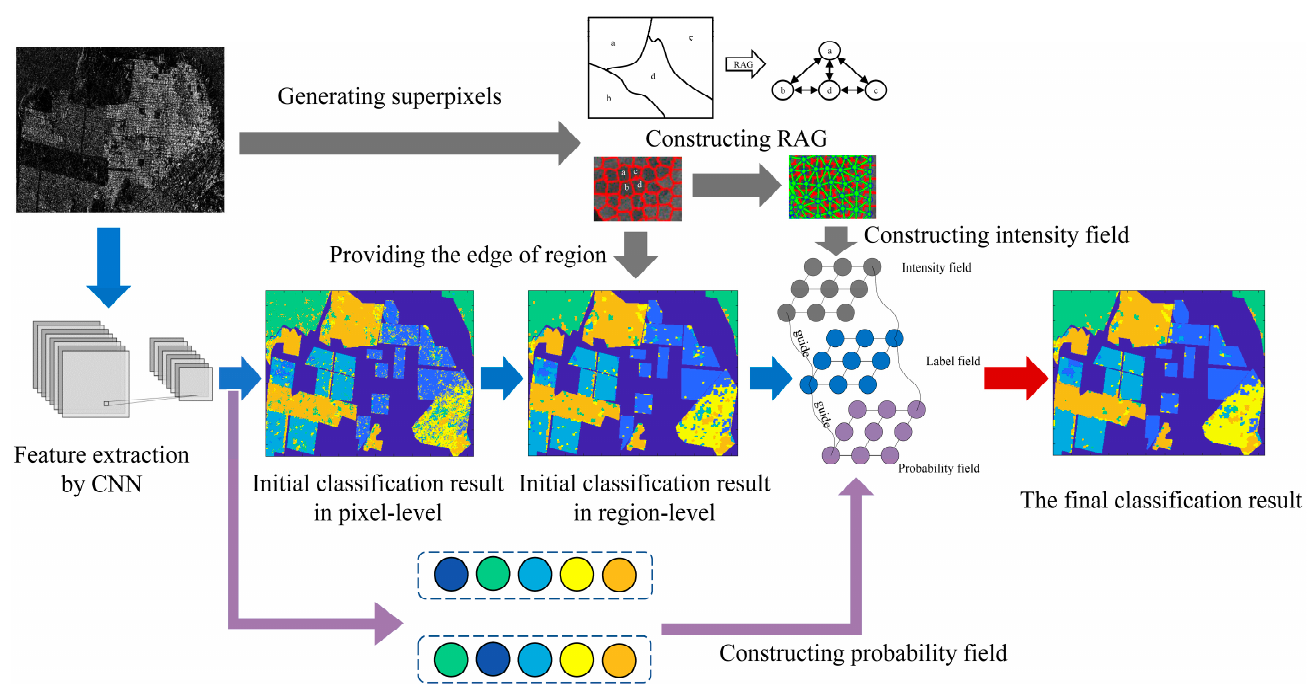
Figure 1. Flowchart of the proposed approach. a, b, c and d are the four adjacent superpixel regions connecting based on the rule of shared boundaries. The grey arrow describes the process of constructing intensity field; the blue arrow describes the process of constructing label field; the purple arrow describes the process of constructing probability field.